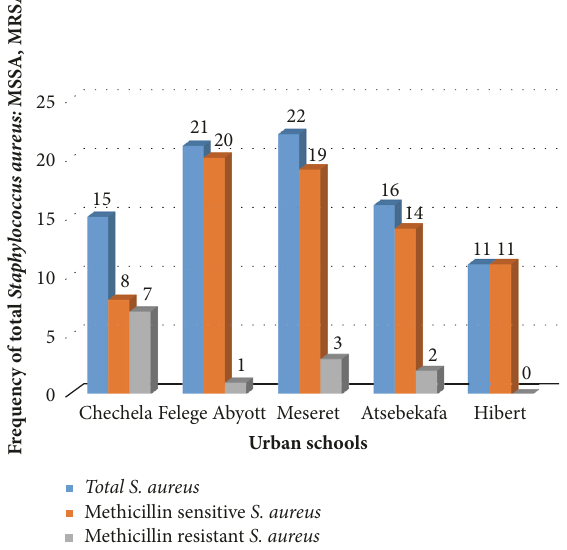
Figure 1: Frequency of total Staphylococcus aureus , MSSA, and MRSA in five urban elementary school children, Gondar town, Northwest Ethiopia, 2018.